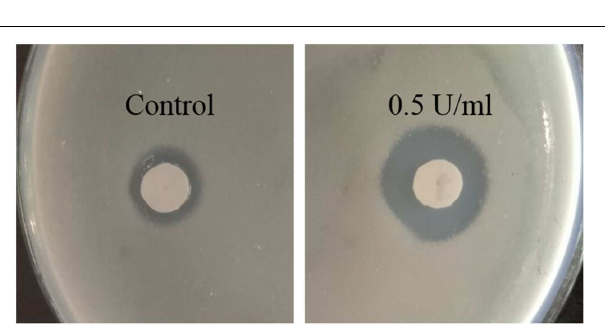
FIGURE 9 | Zone of inhibition by H 2 O 2 of P. aeruginosa PAO1 treated without (control) and with Aii810 at the concentration of 0.5